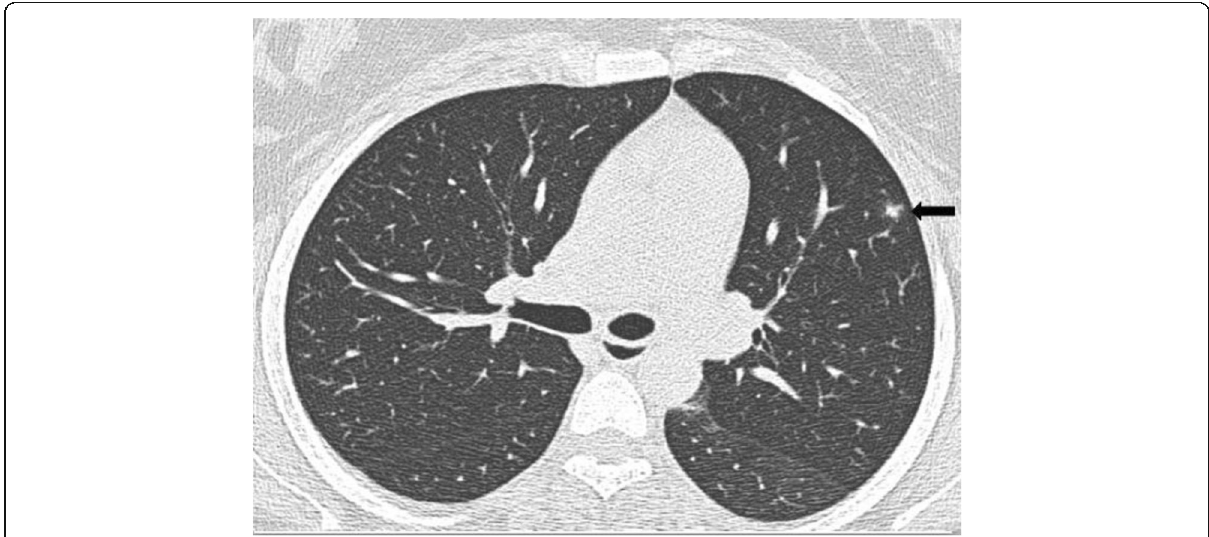
Fig. 7 GGO nodule. Axial CT thorax of a 35-year-old COVID pneumonia patient showing small solitary GGO nodule in the left upper lobe as indicated by the